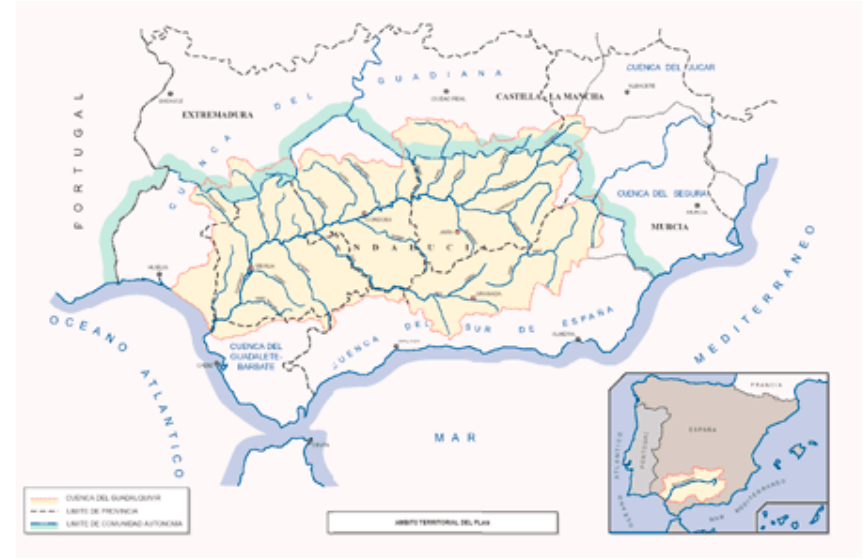
Figure 1. Guadalquivir River Basin District. (Source: Guadalquivir River Basin Authority (GRBA)).